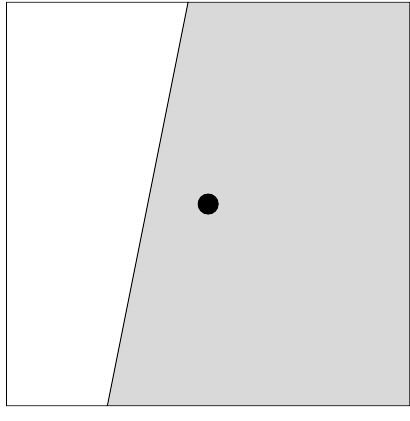
Fig.4 Segment-adaptive similarity correlation